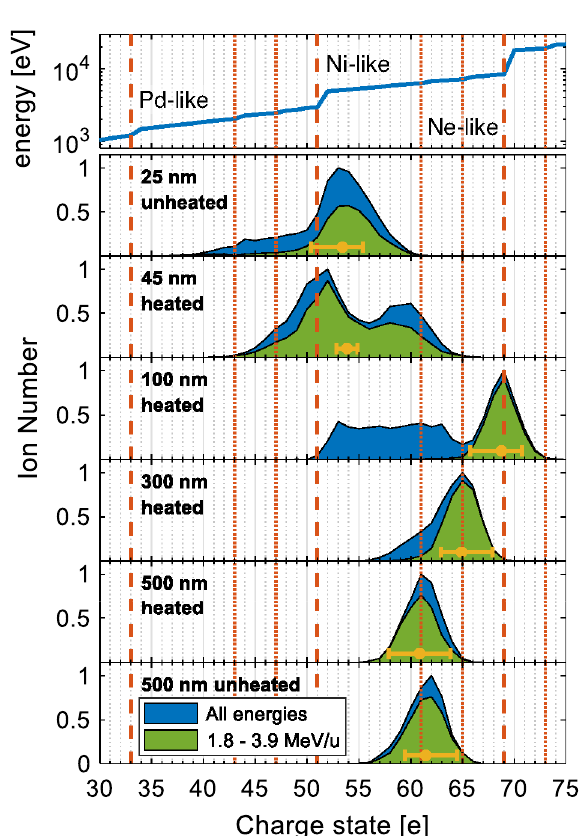
Figure 9. Comparison of the measured gold ion charge states from shots on gold foils with varying thickness to steps in the gold ionization energy indicated by the vertical orange lines (dashed lines correspond to larger, dotted lines to smaller steps). The blue distributions show the gold ion numbers for each charge state integrated over all energies. The green distributions display the number of gold ions integrated between 1.8 and 3.9 MeV/u, for which the individual charge states were resolvable for most of the shots. The yellow point depicts the mean charge state of the green distribution with an error bar showing the uncertainty of the total charge state range. The distributions are normalized to the respective maximum of the blue